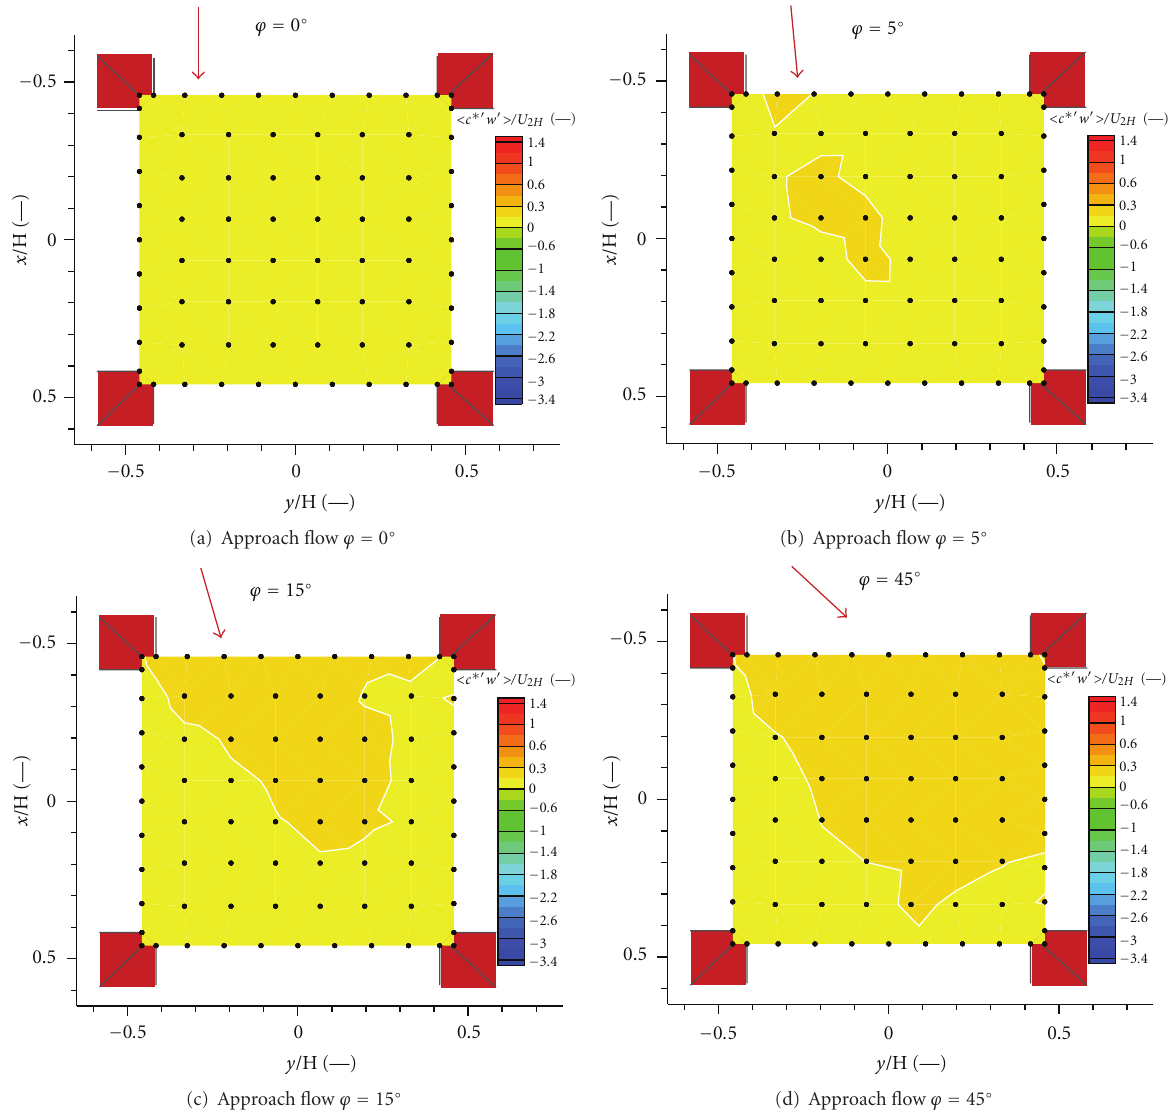
Figure 10: Vertical dimensionless turbulent scalar flux (cid:5) c ∗(cid:6) w (cid:6) (cid:7) /U 2 H for four angles of the approach flow direction.